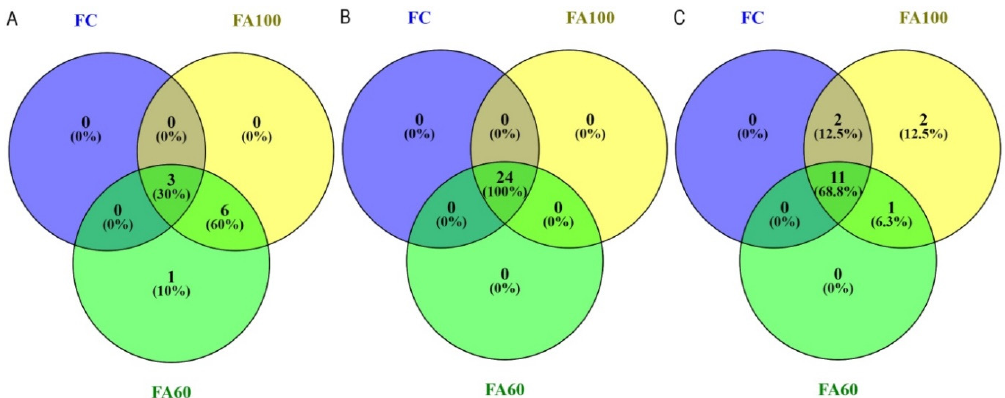
Figure 5. Venn diagrams showing the number of shared and unique terminal restriction fragments among bacteria ( A ), archaea ( B ) and fungi ( C ) communities in Brunic Arenosol soil. Explanation: FC—optimal dose of fertilizer, FA100—optimal dose of fertilizer enriched with microorganisms, FA60—fertilizer enriched with microorganisms (dose reduced by 40%).